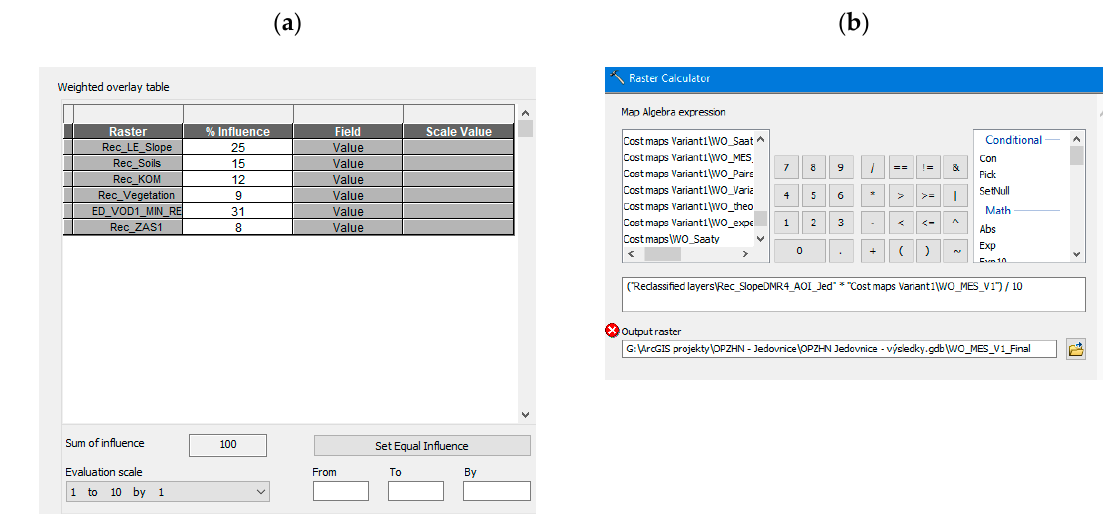
Figure 4. Example of setting the weight values of individual input files for the Weighted Overlay tool ( a ) and the Raster Calculator for calculating the mask of slope inclinations over 5° ( b ).